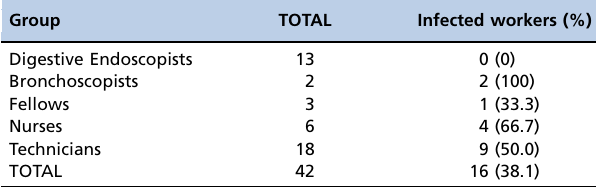
Table 3 - Healthcare worker